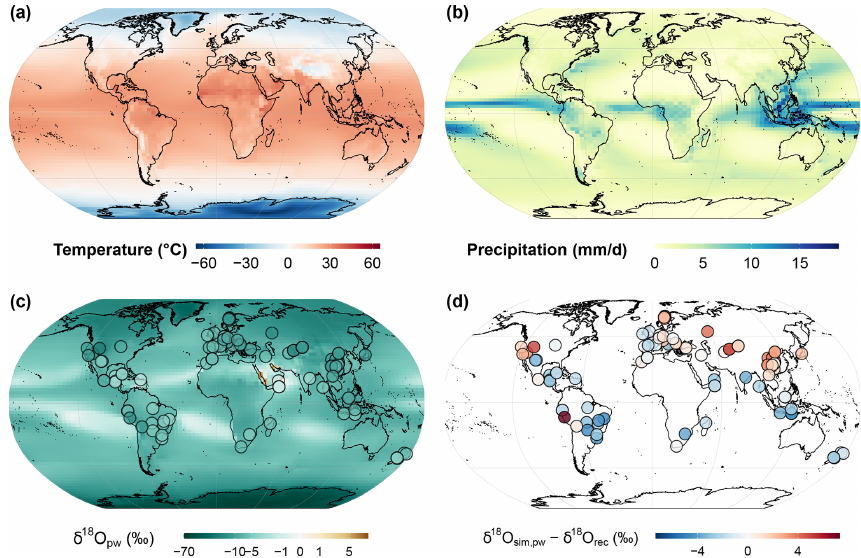
Figure 3. Characterization of the mean state of the simulation (LM1): shown are (a) mean annual surface temperature, (b) precipitation, and (c) δ 18 O pw , including δ 18 O dw . eq at cave sites in drip water equivalents. Note the logarithmic color scale. Point-wise differences between the mean simulated δ 18 O and proxy-based δ 18 O dw . eq (d) show anomalies. Spatially aggregated differences at the global and cluster level for simulations LM1–LM3 are given in Table S1 in the